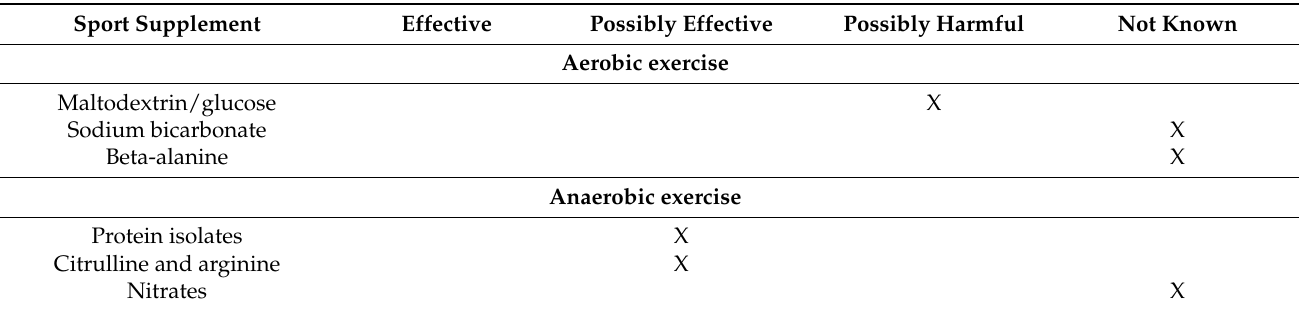
Table 1. Sport supplements and gut microbiota modulation.